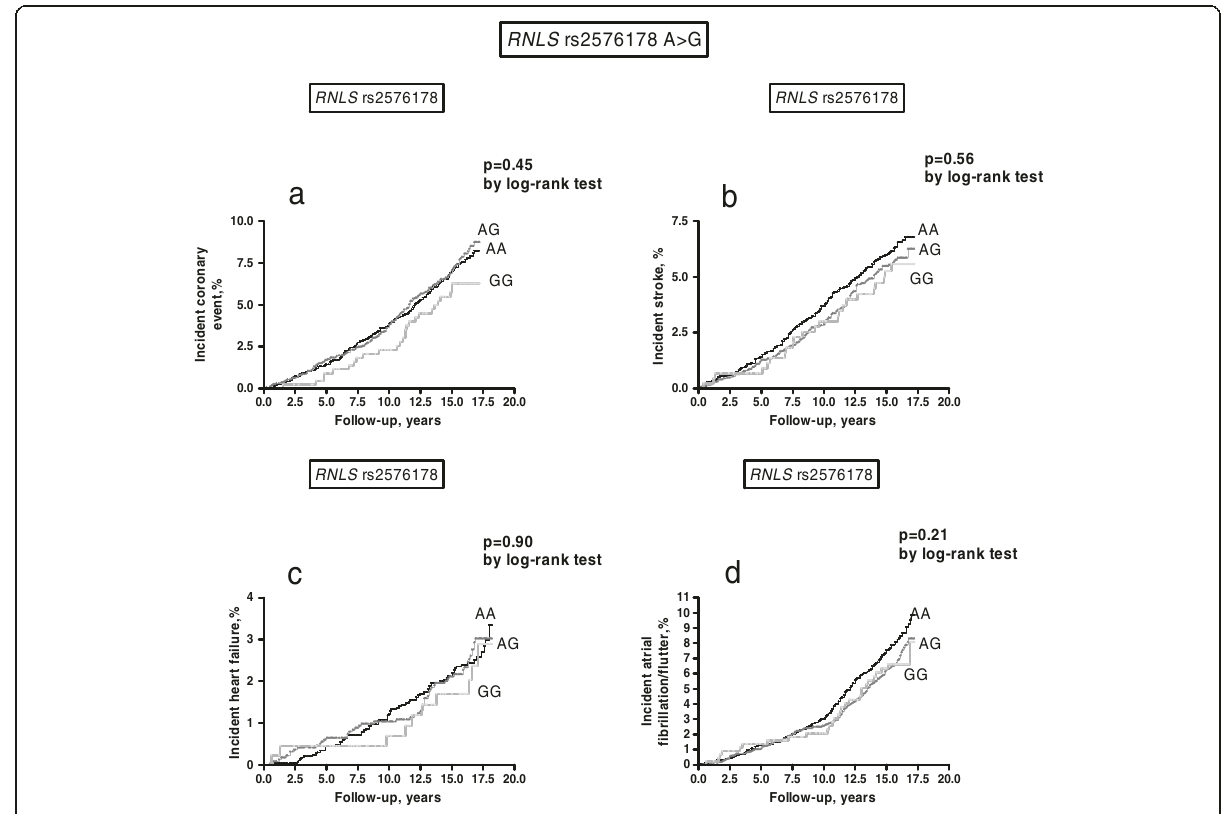
Figure 1 Incident coronary events (a), stroke (b), heart failure events (c), atrial fibrillation/flutter events (d), in carriers of different RNLS rs2576178 A > G